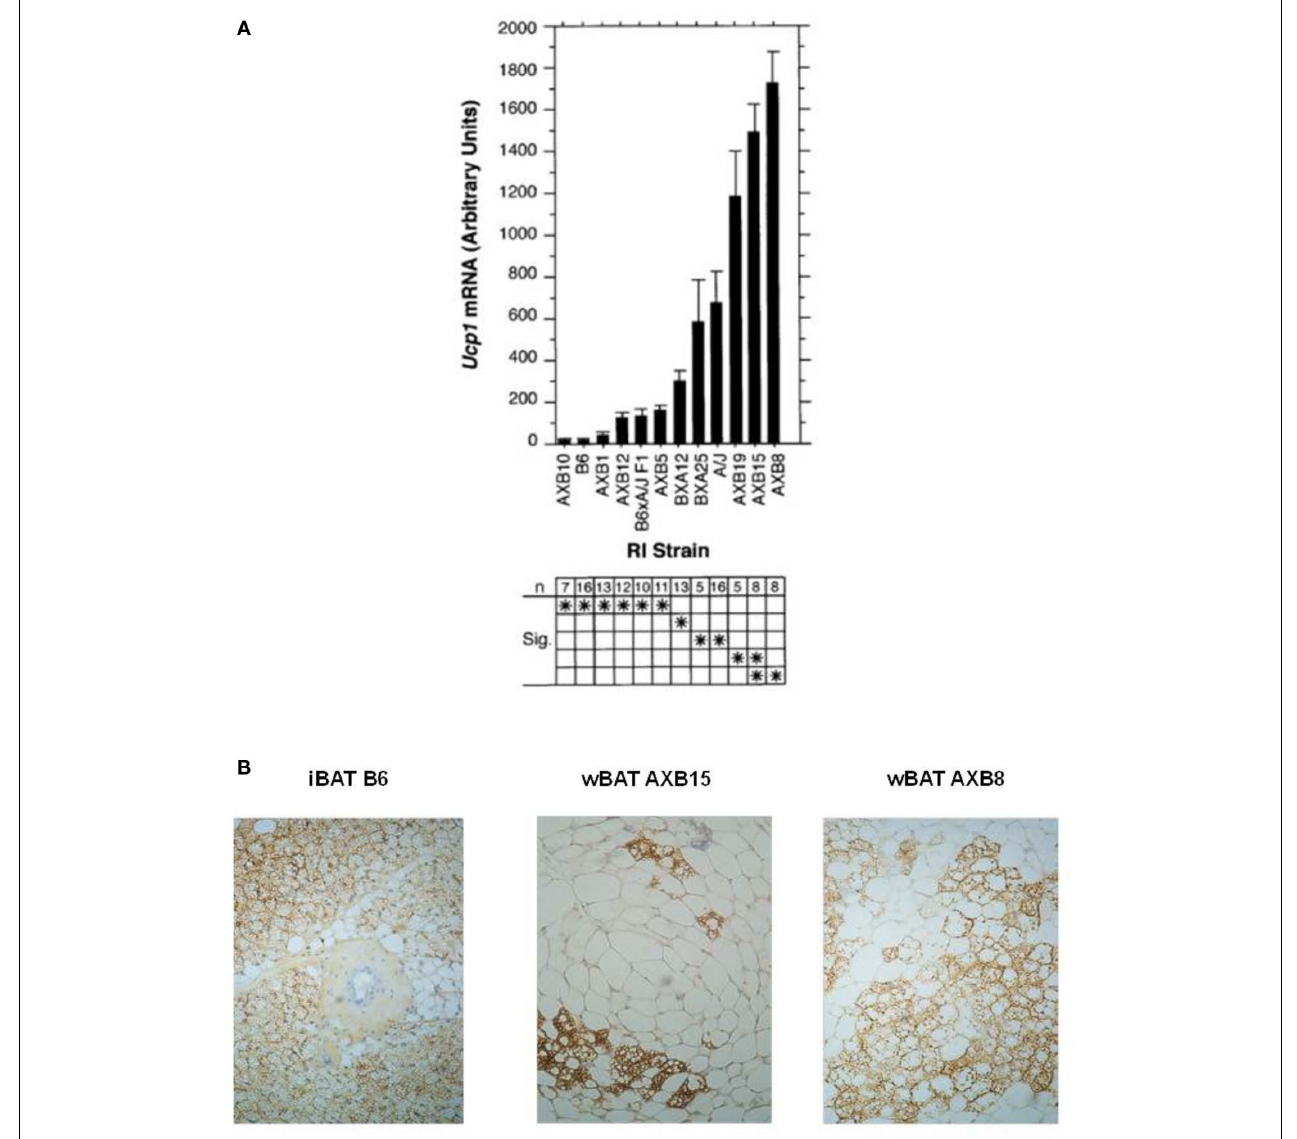
Strains sharing asterisks in a row are not significantly different from each other at P = 0.05. (B) UCP1 immunohistology of paraffin-embedded sections from interscapular brown fat (iBAT) and retroperitoneal fat (wBAT) from A × B8 and A × B15 mice demonstrates the organization of brown adipocytes into clusters that resemble fields of densely packed brown adipocytes characteristic of iBAT.The size of these regions in wBAT may be quite variable, depending upon the strength of the